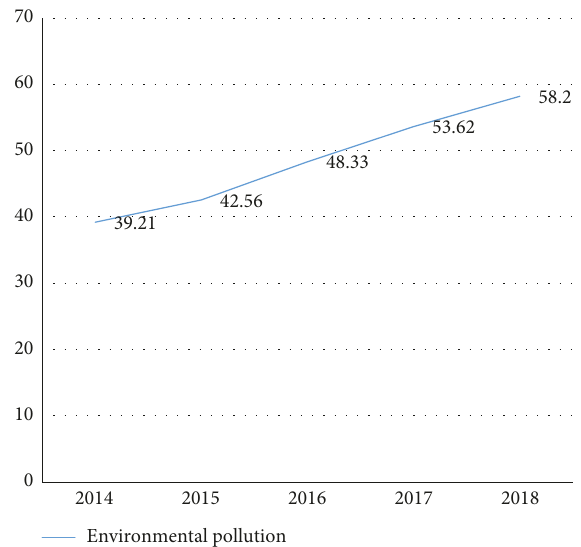
Figure 1: Environmental pollution trend in domestic rural cultural industry in